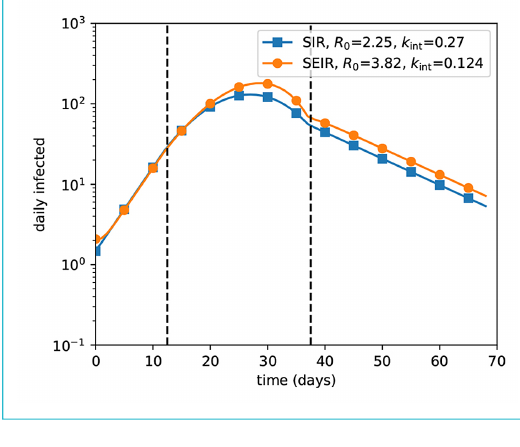
−1 = 5.2 days, t 0 = 2.25, γ int = 25, δ int = 25, and k int = 0.27. Para- meters of SEIR: R 0 = 3.82, γ −1 = 5.2 days, α −1 = 2:9 days [24], t int = 25, δ int = 25, and k int = 0.124. Values of R 0 and k int were chosen to match the growth rates of both models before and after interven- tions following (7). Black dashed lines show the transition range t int ± ½ δ int .